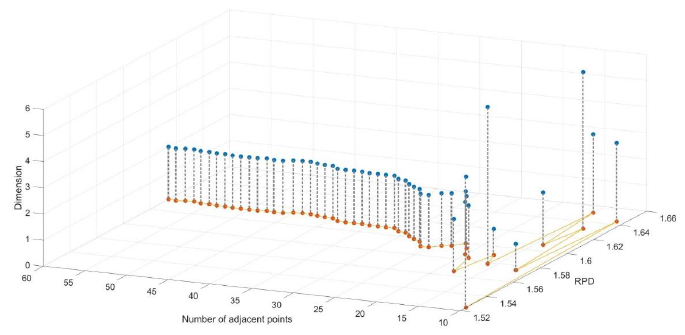
Figure A1. Number of adjacent points in different dimension number versus RPD. The dimension number is determined by the dimension corresponding to the optimal RPD among 0–200 dimensions in the case that the number of adjacent points is the same.